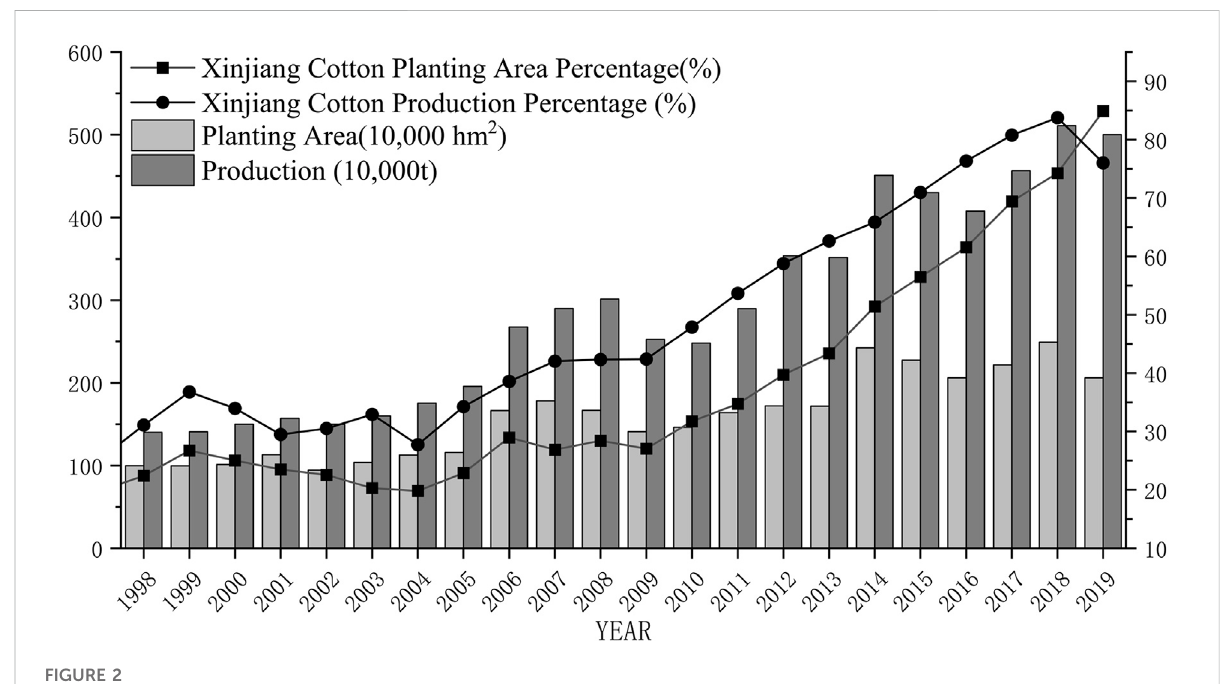
FIGURE 2 Cotton production and planting area in Xinjiang, 1998 –